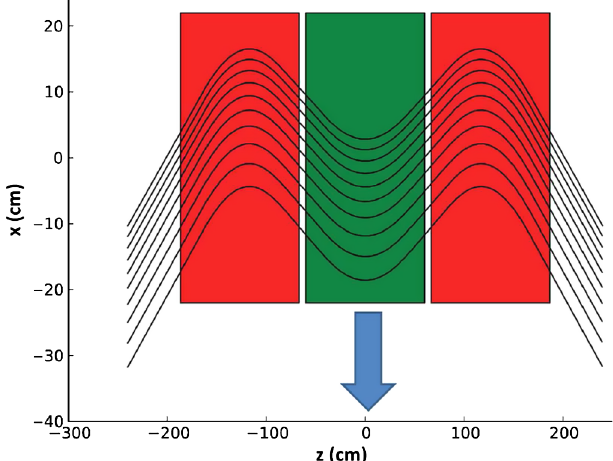
FIG. 16. Typical particle traces through the PAMELA triplet; the F and D magnets are indicated schematically by the red and green boxes, and the blue arrow shows the direction in which the D magnet must be displaced for the offset solution.